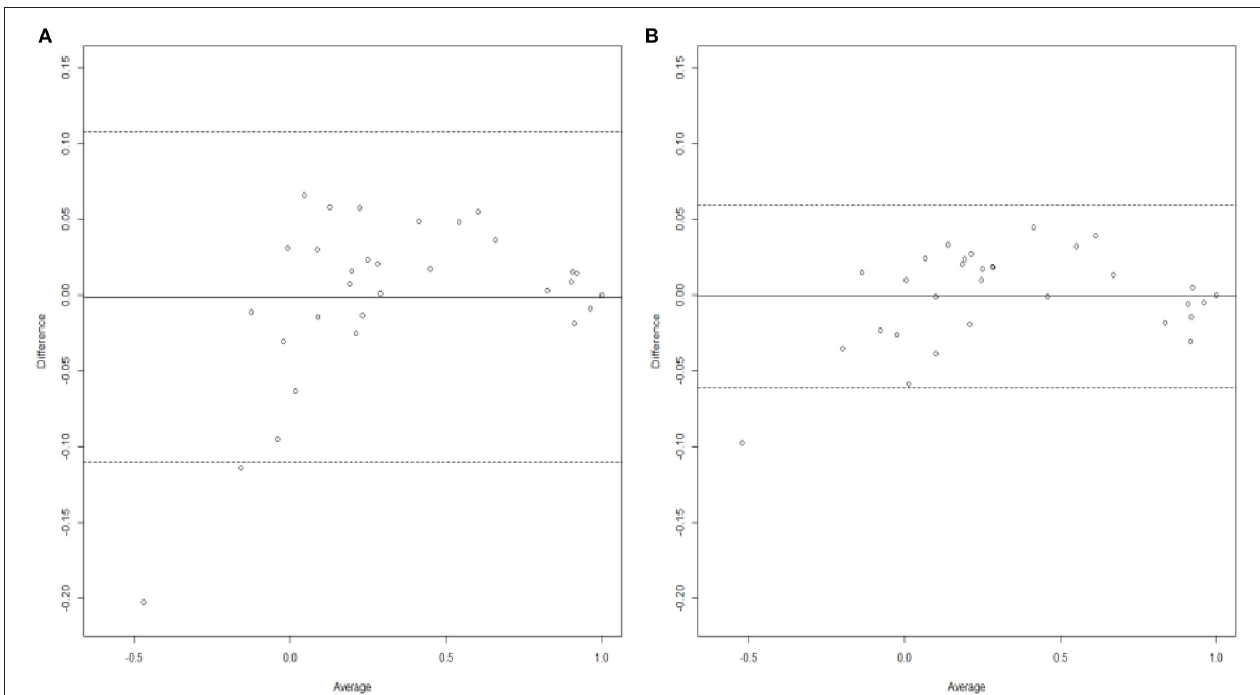
FIGURE 4 | Bland-Altman plots generated from analyzing (A) Polish data only and (B) Polish data with Irish results as informative